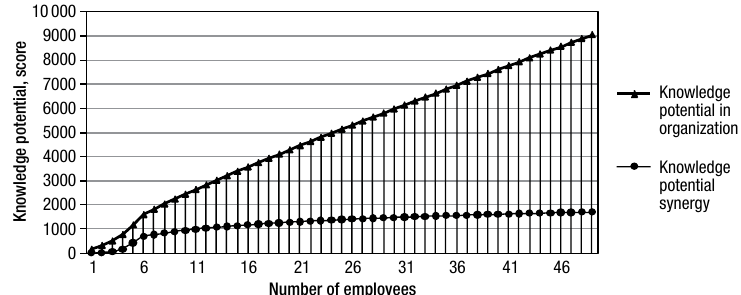
= 150 score; µ (when P di